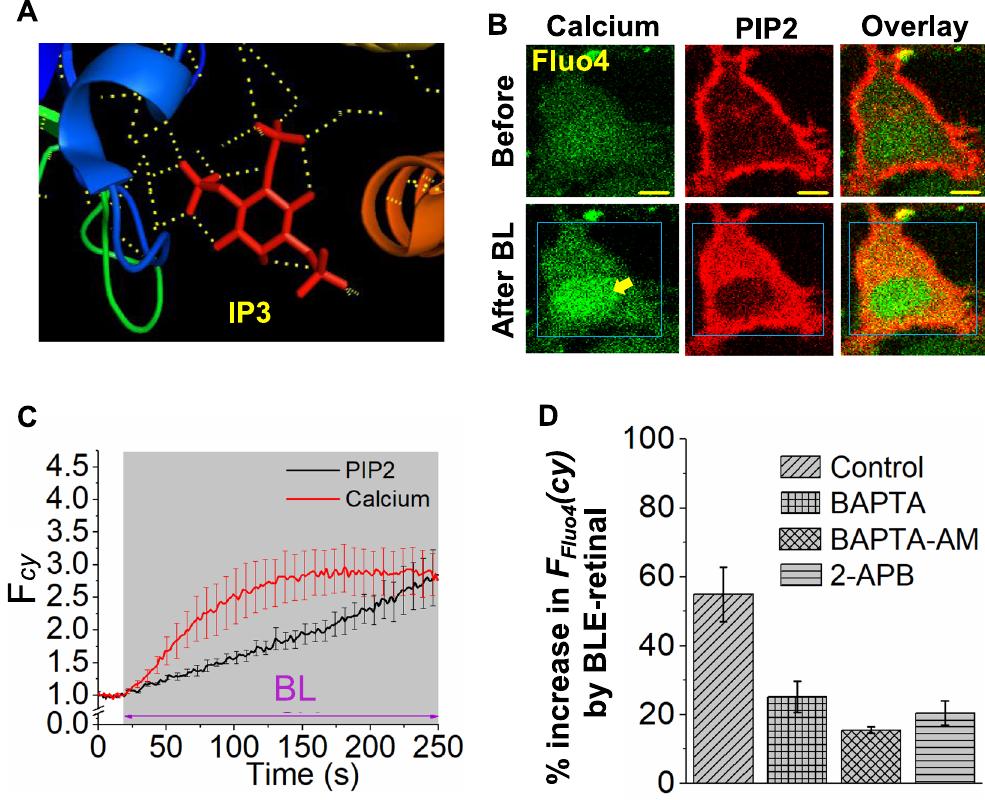
Figure 6. All trans retinal and blue light induced signaling in cells. ( A) Crystal structure of the IP3 receptor bound with IP3 with H-bonding interactions (PDB code:1N4K), suggesting the PIP2 can have the majority of interactions exhibited by IP3. ( B) HeLa cells expressing PIP2 sensor (mCherry-PH) and incubated with calcium sensor Fluo4. Fluo4 stained cells were incubated with ATR (50 µ M) for 5 minutes, followed by exposure of blue light (4.86 µ W of 445 nm) for 3 minutes. Here the whole cell was exposed to blue light. A substantial increase in cytosolic calcium is observed. ( C ) Dynamics of calcium responses and PIP2 translocation in the cells shown in B (mean ± S.E.M., n = 5 cells). ( D ) Calcium responses in control and calcium modulator-incubated (using BAPTA-AM and 2-APB) HeLa cells in regular and extracellular calcium free (using BAPTA) buffers. Here, cells were pre-incubated Fluo4 were incubated with 2-APB (5 µ M for 15 min), BAPTA-AM (10 µ M for 30 min), or BAPTA (5 µ M for 5 min) in calcium free HBSS buffer. The cells were then incubated with ATR (50 µ M) for 5 minutes, followed by continuous exposure of blue light for 5 minutes. The bar chart shows the changes in calcium sensor fluorescence in the cytosol before and after blue light exposure on cells for all the above mentioned experiments (mean ± S.E.M., n = 5–15 cells). Mean and S.E.M. are from 3 < independent experiments. (blue light (BL) = blue box). Scale = 5 µ